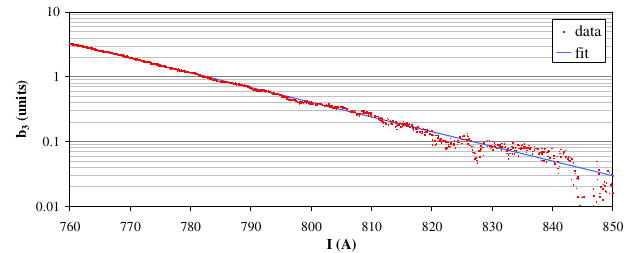
FIG. 8. (Color) Exponential fit of measured sextupole change during snap-back on the LHC dipole 2211.